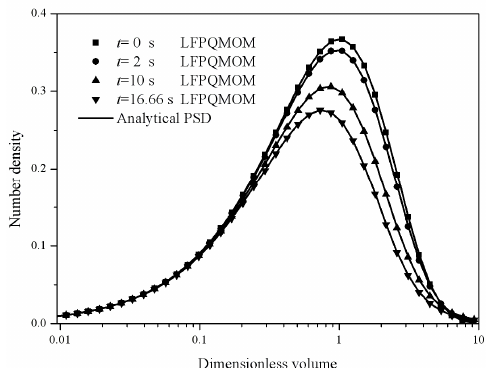
Figure 12. Particle size distributions at 0, 2, 10, and 16.66 s for the pure aggregation process with product kernel and Gaussian initial PSD (square: numerical PSD at 0 s; circle: numerical PSD at 2 s; up triangle: numerical PSD at 10 s; down triangle: numerical PSD at 16.66 s; line: analytical PSD).